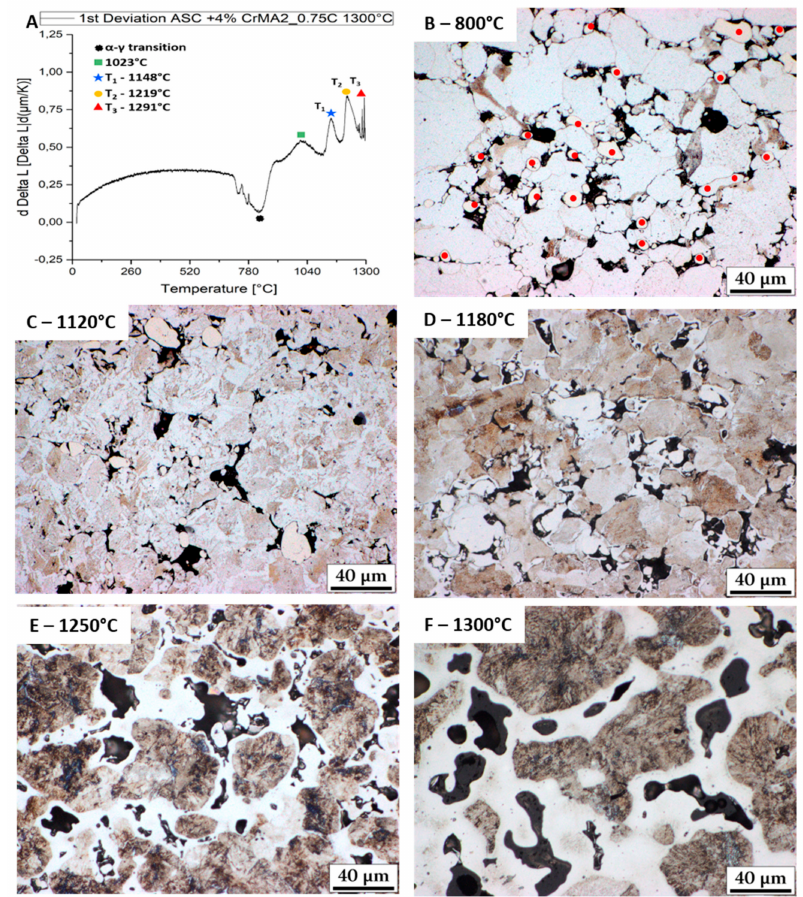
Figure 3. Fast heating experiment (120 K/s) with ASC + 4% CrMA2_0.75Cnom (0.72Ccomb). ( A ) 1st Dev of the dilatometer (heating segment) ( B ) 800 ◦ C preheated in pusher furnace. Starting point (red dots mark MA) ( C ) Sample quenched from 1120 ◦ C, ( D ) Sample quenched from 1180 ◦ C, ( E ) Sample quenched from 1250 ◦ C and ( F ) Sample quenched from 1300 ◦